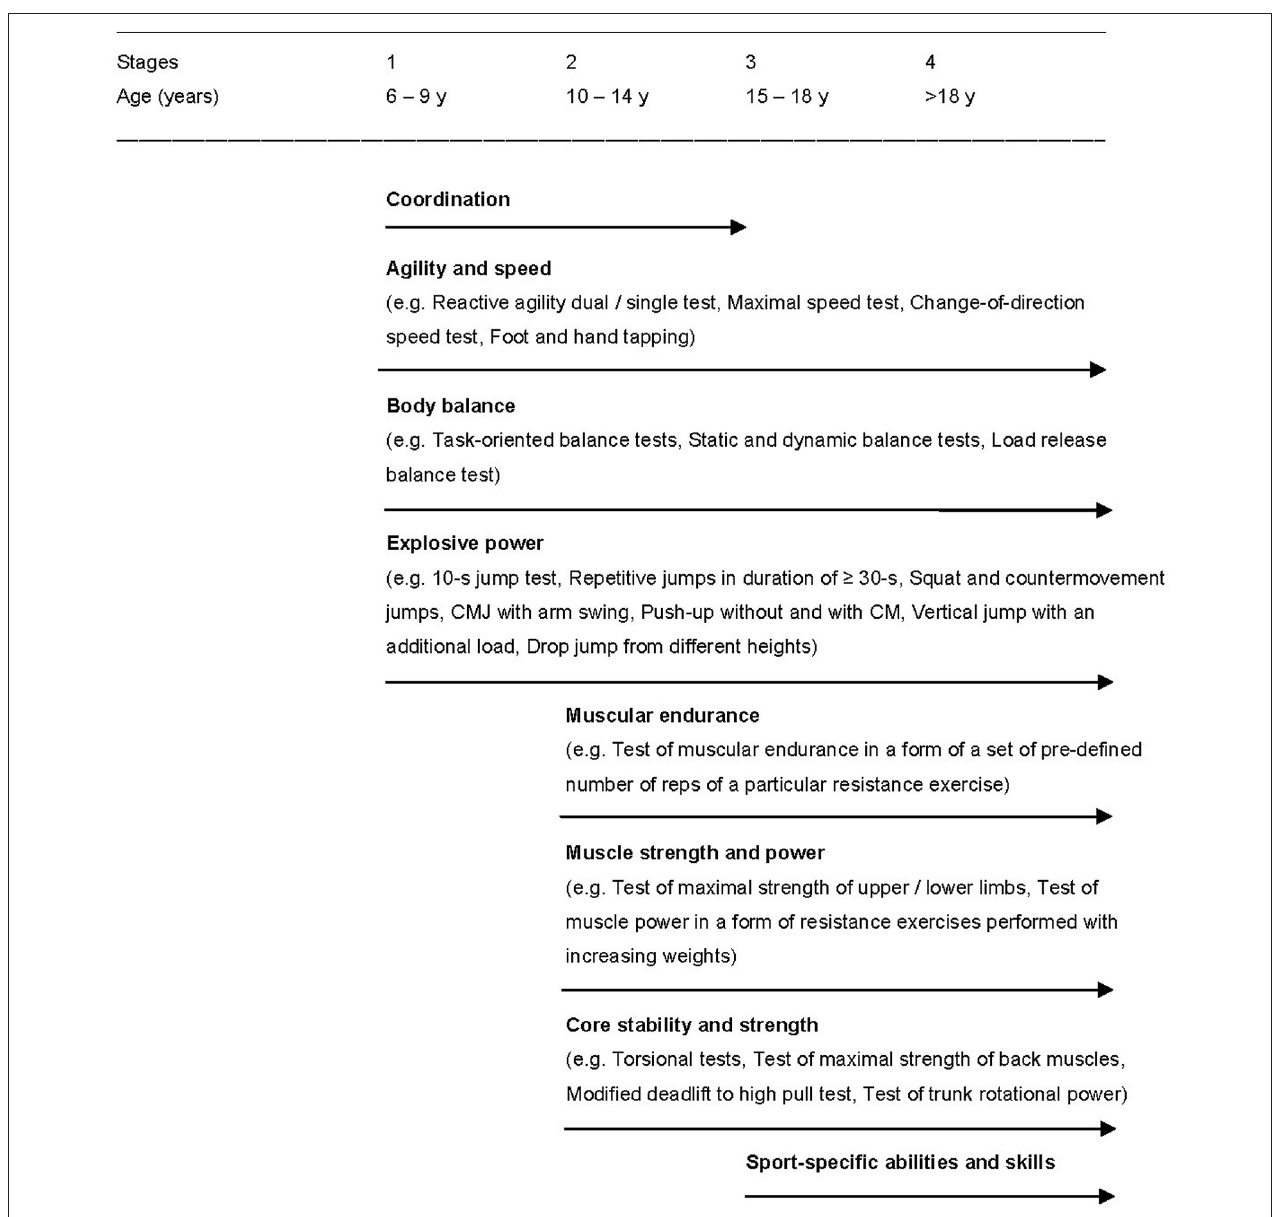
FIGURE 1 | Proposed tests within the abridged Long-Term Sport Diagnostic Model for evaluation of the effect of neuromuscular training on physical fitness in young athletes.